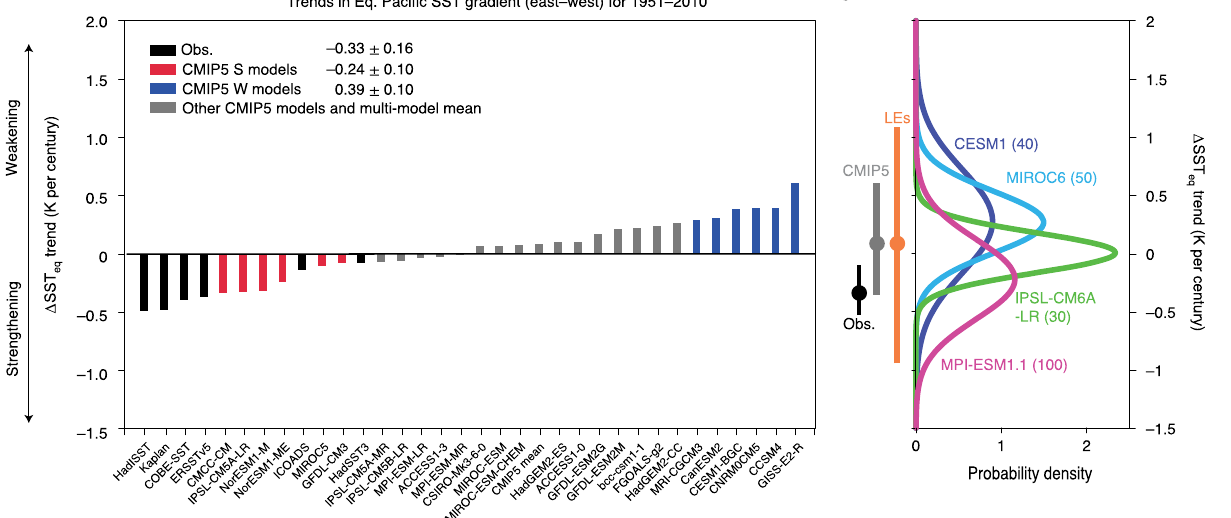
Fig. 2 Equatorial Paci fi c zonal SST gradient trend during 1951-2010. a Linear trends for 1951 – 2010 of the equatorial Paci fi c zonal SST gradient, de fi ned as the eastern Paci fi c (180 o -80 o W, 5 o S-5 o N) SST minus the western Paci fi c (110 o E-180 o , 5 o S-5 o N) SST from six observational data sources (Obs), and 27 CMIP5 models. The S group (six models that show the largest magnitude of SST gradient strengthening) of CMIP5 models show a strengthening of the zonal SST gradient, and the W group (six models that show the largest magnitude of SST gradient weakening) of CMIP5 models show a weakening of the zonal SST gradient. b Probability density function of the 1951-2010 SST gradient trends in four large ensemble simulations indicated in the fi gure. The ensemble size is indicated in parentheses. Dots and bars in the left margin of b indicate the means and 5 – 95% ranges for the observations, CMIP5 models (one realization from each model) and combined large ensemble simulations. (Adapted from ref. 26